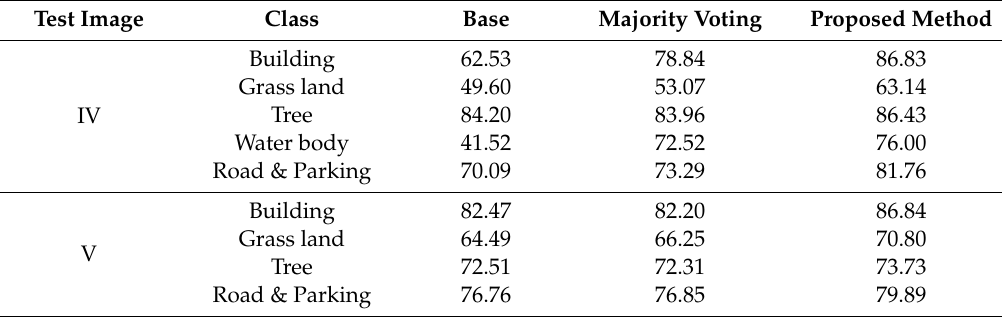
Table 2. Results of F1_score evaluation parameters, per class in test images.